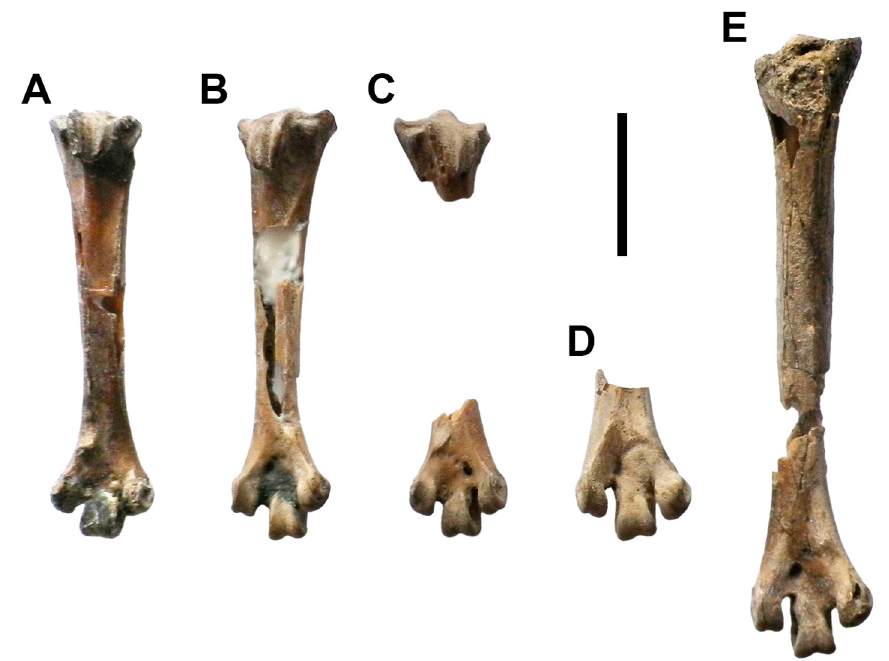
Figure 6. Caudal aspect of tarsometatarsi of London Clay screamer-like Anseriformes familia incertae sedis: holotype of Danielsavis nazensis nov. gen. et sp. (NMS.Z.2021.40.1) left ( A ), left (NMS.Z.2021.40.6) ( B ), proximal and distal extremities of right (NMS.Z.2021.40.3) ( C ), distal left (NMS.Z.2021.40.5) ( D ), left (NMS.Z.2021.40.4) ( E ). Scale bar 1 cm.